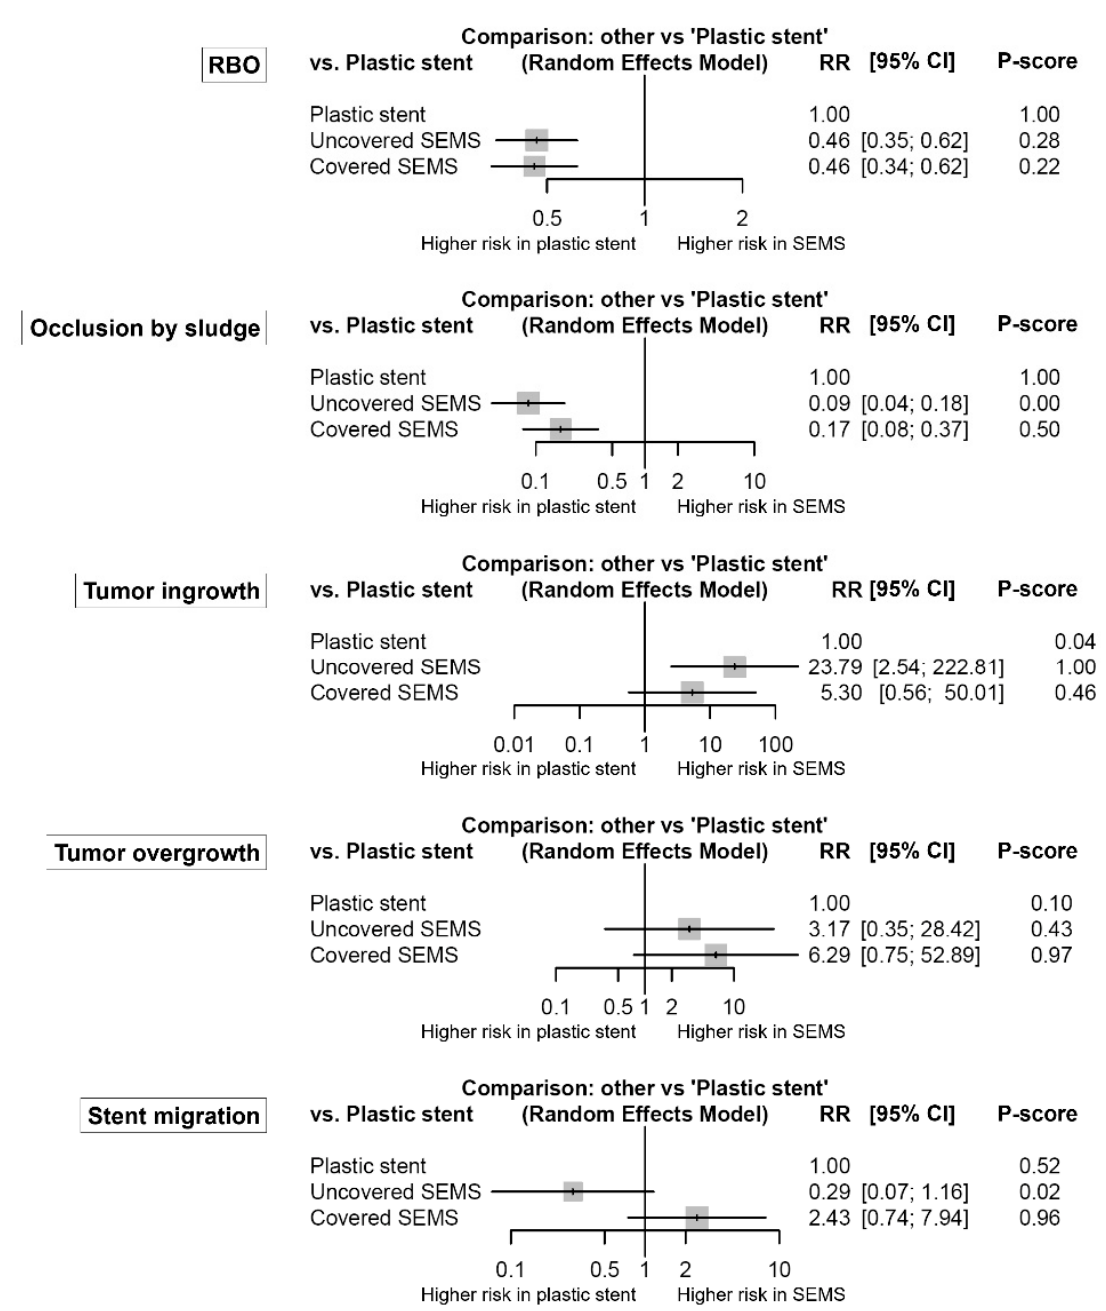
Figure 3. Comparative efficacy for recurrent biliary obstruction and its causes according to the type of stents from the network meta-analysis. The P-score indicates the mean extent of certainty that one type of stent is better than another. RBO, recurrent biliary obstruction; SEMS, self-expandable metal stent; RR, risk ratio; CI, confidence interval.